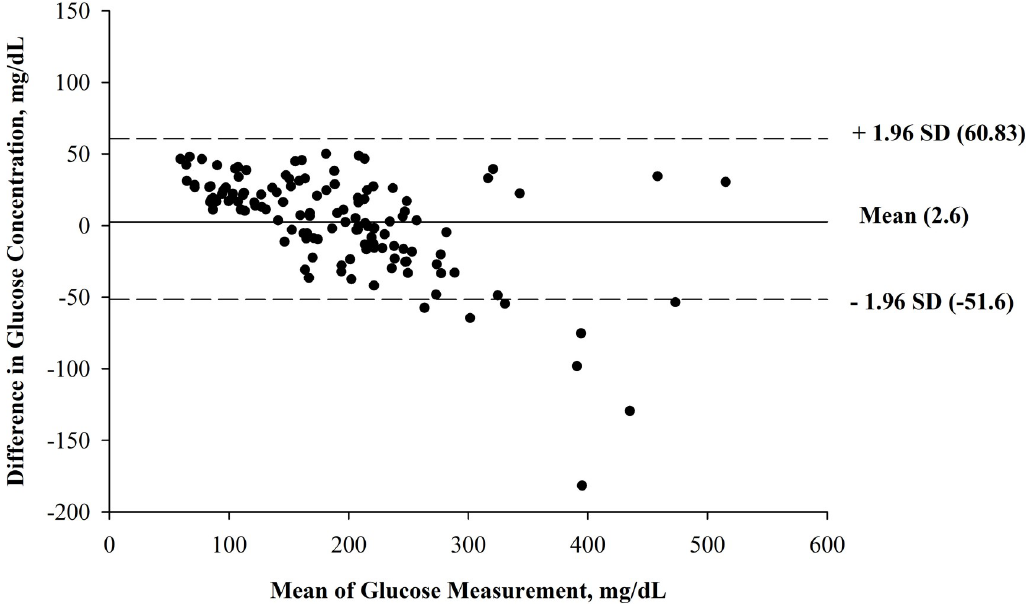
Fig 2. Bland-Altman plot of the raw data (N = 130 samples from 13 steers), with the mean glucose concentration as measured by the glucometer (Precision Xtra; Abbott Diabetes Care, Inc., Mississauga, ON, Canada) and the plasma preserved in sodium fluoride tubes and analyzed in a laboratory with a colorimetric assay (Stanbio Glucose LiquiColor (Oxidase) Procedure, Stanbio Laboratory, Boerne, TX, USA) on the x-axis, plotted against the difference in glucose concentrations determined by the glucometer and the laboratory on the y-axis. The mean difference is represented by the solid line (mean = 4.6) and the 95% confidence limits are represented by the dashed lines.